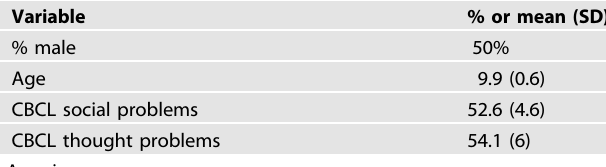
Table 2. Autism-related CBCL behavior traits and demographic summary of ABCD individuals in this study ( N =